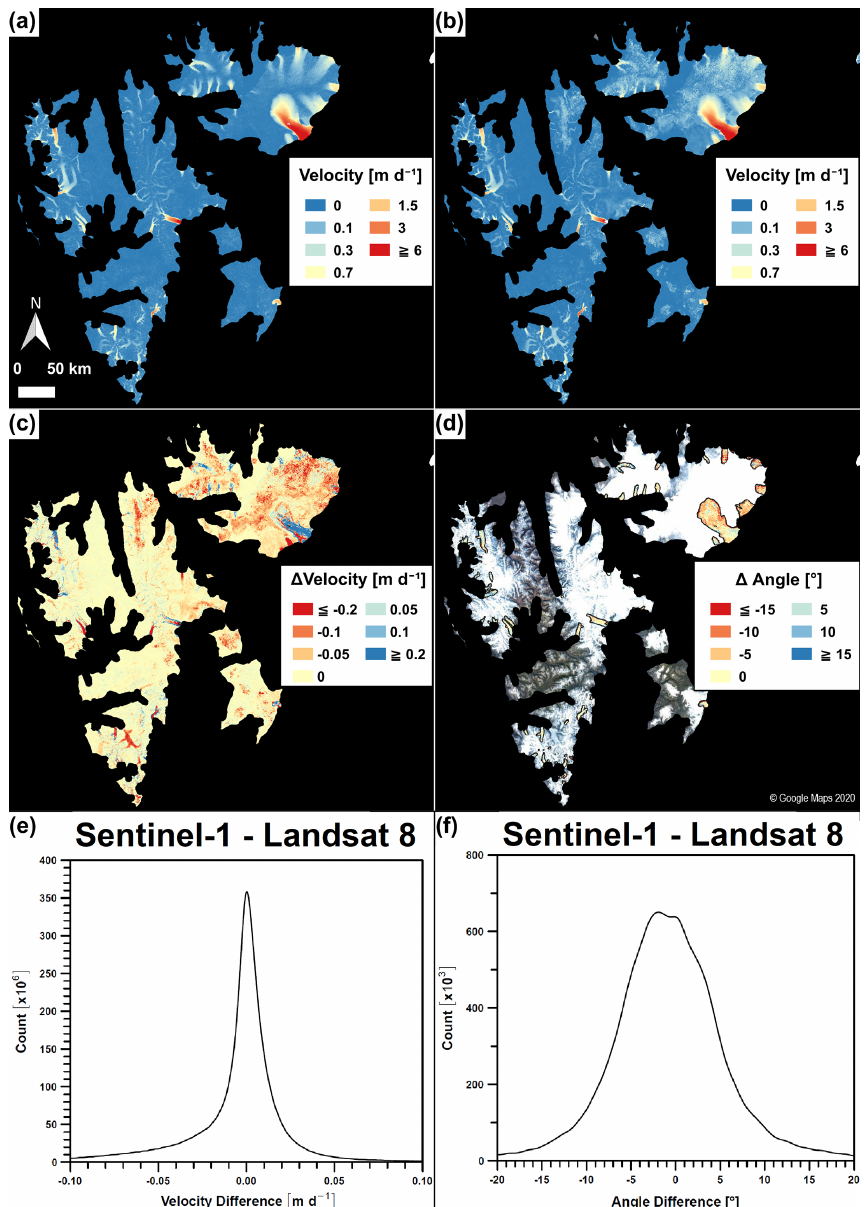
Figure 10. Comparison of a Sentinel-1 surface velocity mosaic with a Landsat-8 ITS_LIVE velocity mosaic from 2018. (a) Sentinel- 1 weighted mean of the velocity magnitude, (b) Landsat-8 weighted mean of the velocity magnitude, (c) velocity magnitude difference (Sentinel-1 minus Landsat-8), (d) displacement angle difference in regions with surface velocities of > 0.3md − 1 (Sentinel-1 minus Landsat- 8), (e) distribution of the velocity differences, and (f) distribution of the displacement angle differences. Background: © Google Maps 2020, overlain by an OpenStreetMap-based ocean polygon data set in black (https://osmdata.openstreetmap.de/data/water-polygons.html,